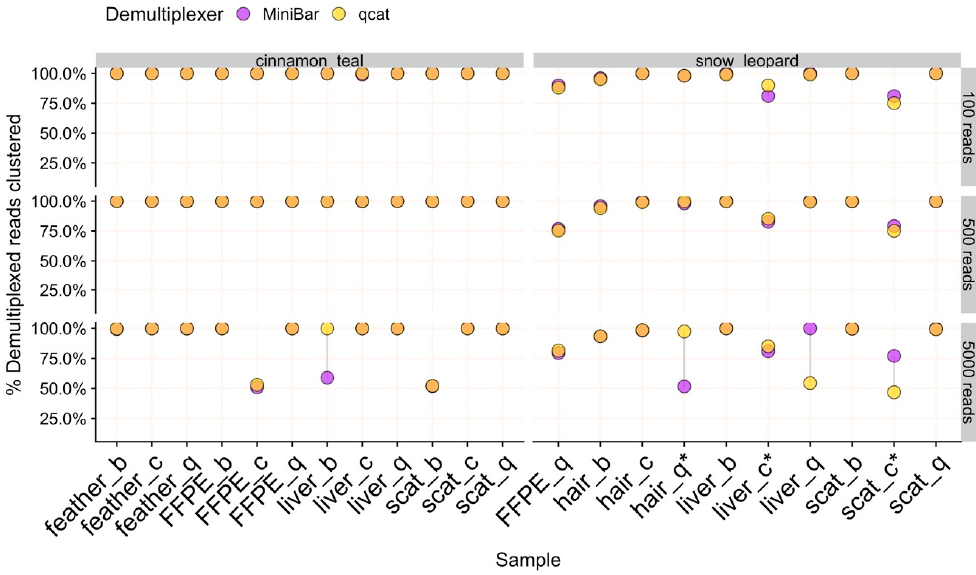
Figure 3. The percent of demultiplexed reads used to generate the final consensus sequence for 100R, 500R, and 5KR subsets for each species. Samples are labeled by tissue type and extraction method (b = biomeme, c = chelex, q = qiagen). Points are linked by a grey line to show di ff erence in values from demultiplexers. Overlapping areas in orange indicate similar results for Minibar and qcat analyses. Asterisks (*) indicate samples with cinnamon teal